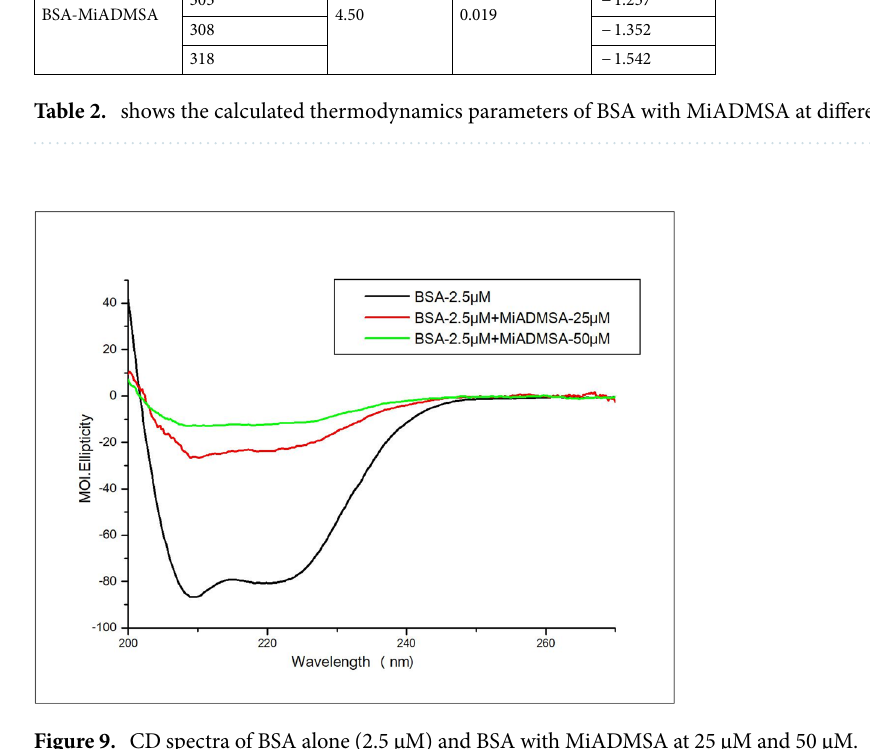
Figure 9. CD spectra of BSA alone (2.5 µM) and BSA with MiADMSA at 25 µM and 50